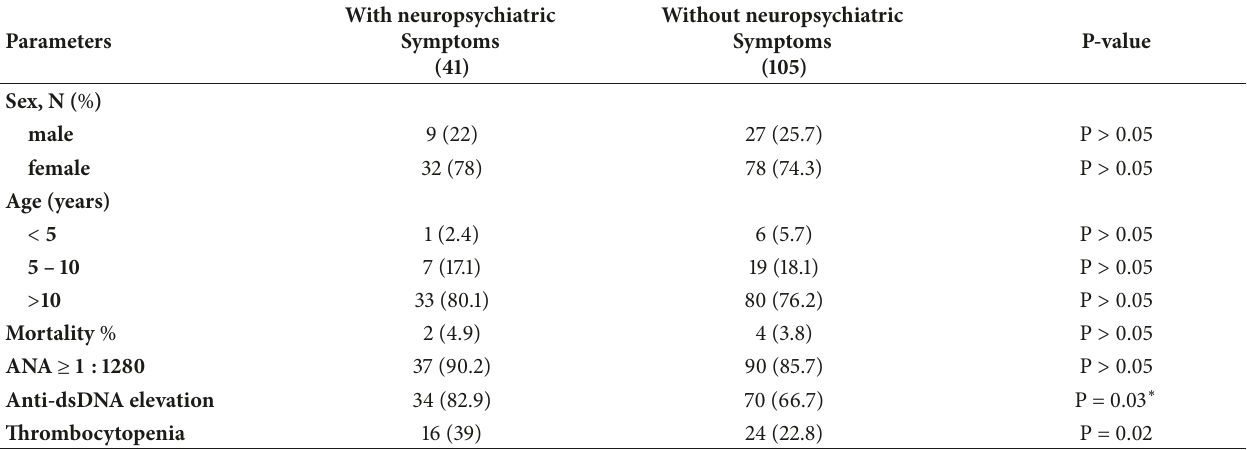
Table 1: Comparison between patients with and without nervous system involvement in juvenile systemic lupus erythematosus. With neuropsychiatric Parameters